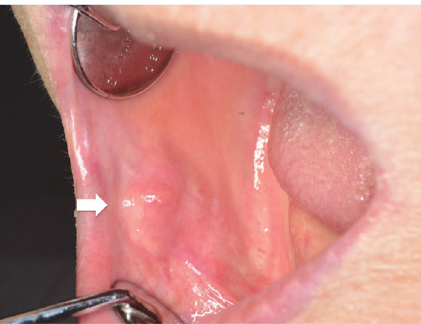
Figure 3: Intraoperative